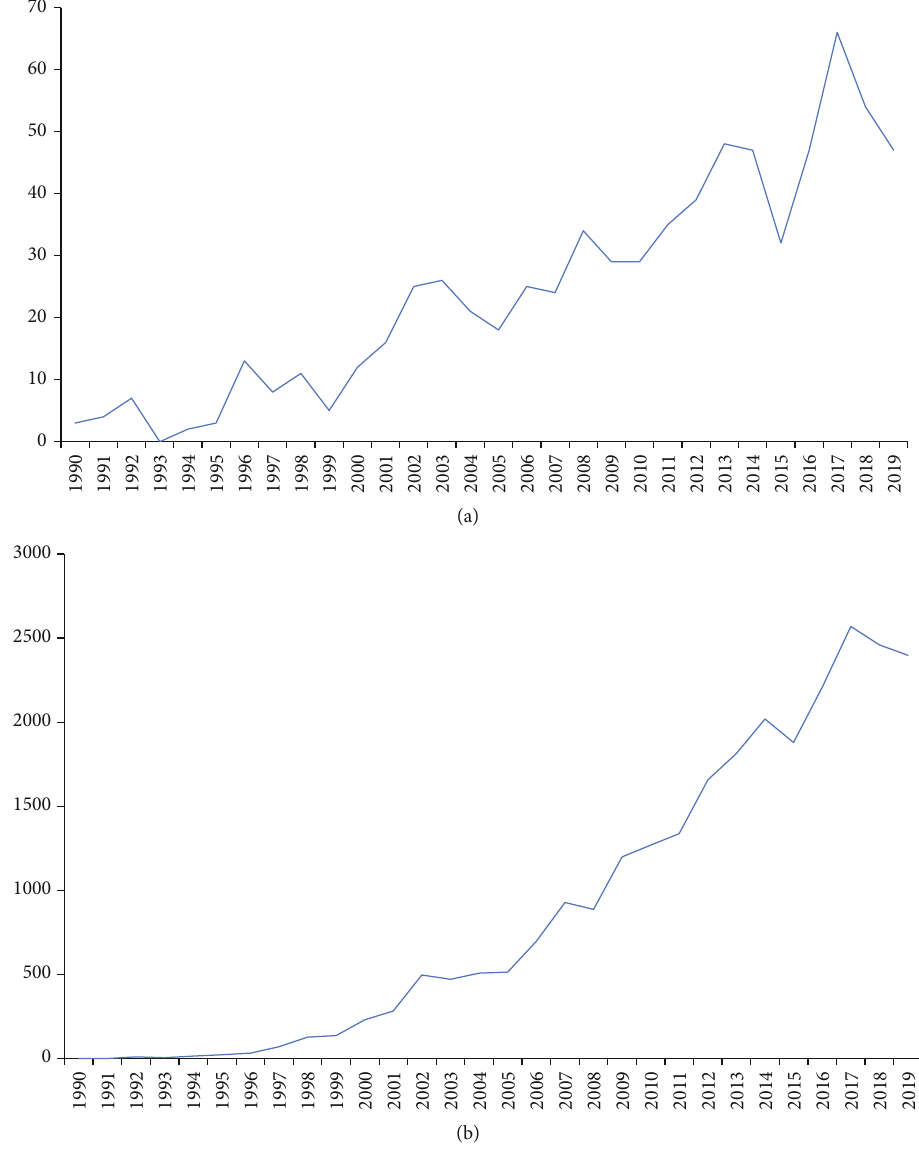
Figure 1: Number of publications and citations. (a) The number of annual publications on pain after spinal cord injury research from 1990 to 2019. (b) The number of annual citations on pain after spinal cord injury research from 1990 to